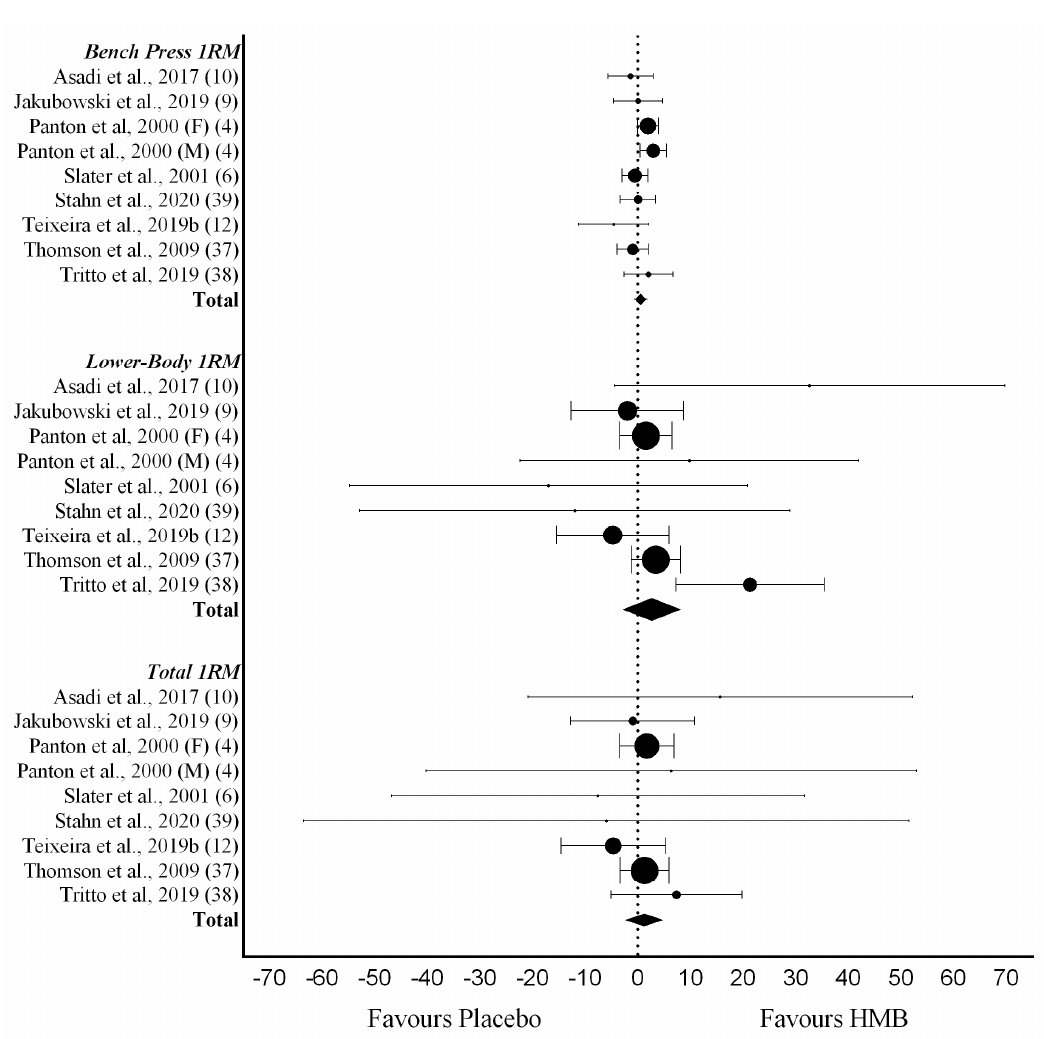
Figure 3. Forest plot of a random-e ff ects meta-analysis for the e ff ect of HMB supplementation on changes in strength. Eight studies (nine trials) were analyzed for bench press 1RM, lower body 1RM (kg) and total 1RM. Results are presented as mean di ff erence between HMB supplemented (Experimental) and Placebo group with 95% CIs. HMB, β -hydroxy- β -methylbutyrate; CIs, Confidence